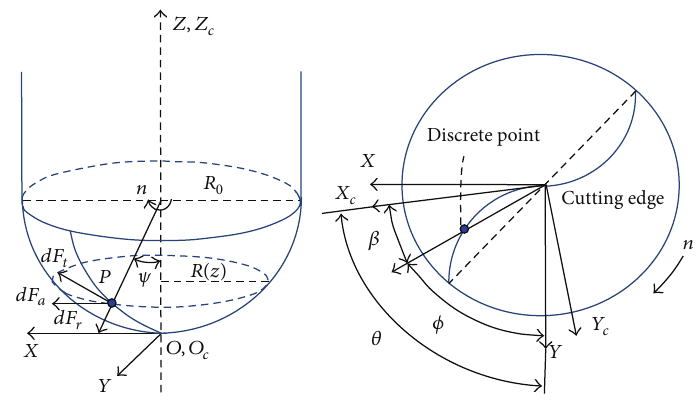
Figure 2: Geometry model of the ball-end